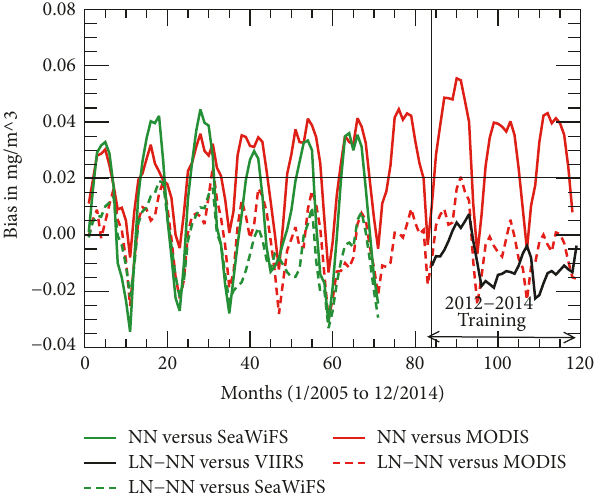
Figure 12: Biases of monthly mean chl-a concentrations simulated byNN(solid)andLN-NN(dashed)ensemblesversusVIIRS(black), MODIS (red), and SeaWiFS (green)